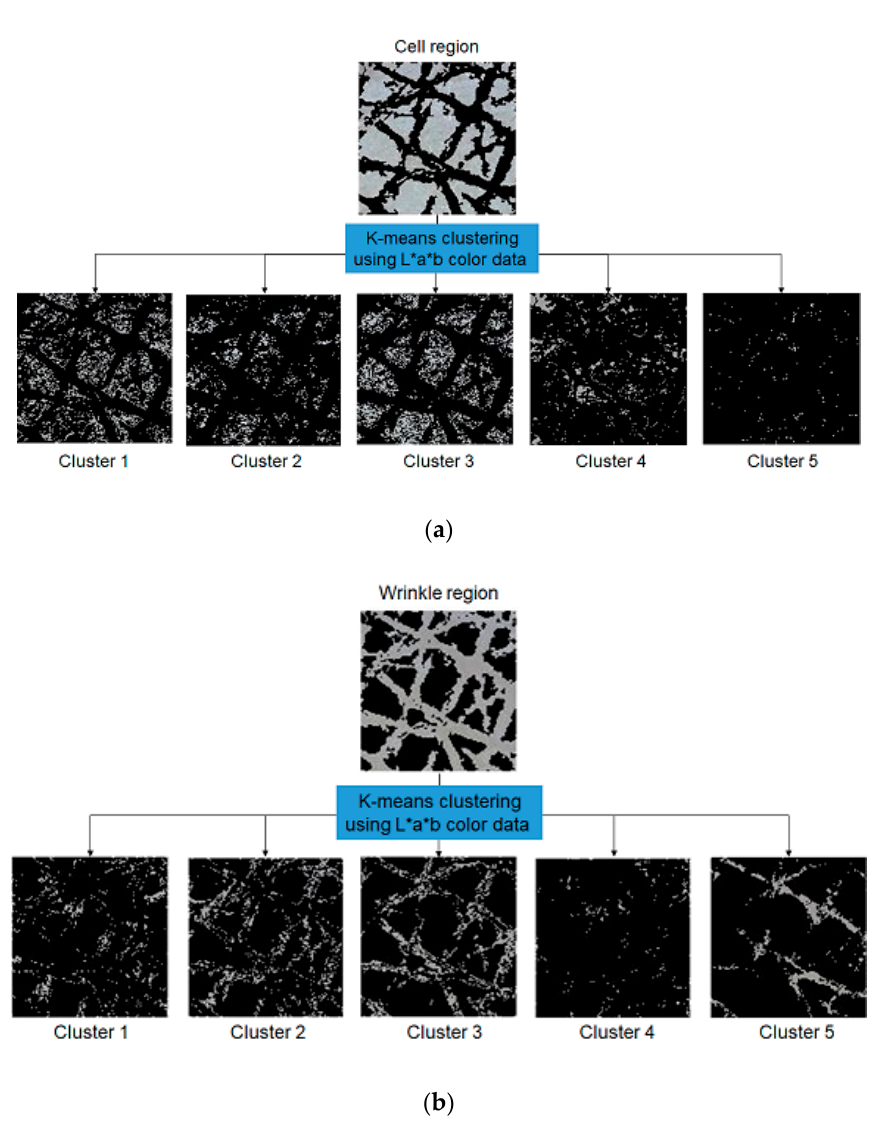
Figure 4. Cell and wrinkle regions clustering using L*a*b* color space and K-means (K = 5)—( a ) cell; ( b ) wrinkle.